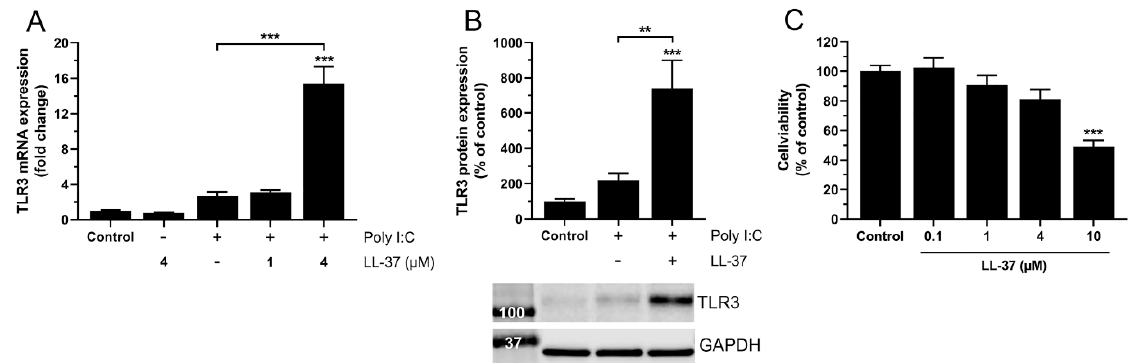
Figure 4. High but not low concentration of LL-37 stimulates poly I:C-induced upregulation of TLR3 in BEAS-2B cells. ( A ) TLR3 mRNA expression was evaluated using quantitative real-time RT-qPCR in cells treated with poly I:C (0.2 µg/mL), LL-37 (4 µM) or LL-37 (1 and 4 µM) and poly I:C (0.2 µg/mL) in combination for 24 h. ( B ) TLR3 protein expression was evaluated using Western blot in cells treated with poly I:C (0.2 µg/mL) alone or poly I:C in combination with LL-37 (4 µM) for 24 h. The TLR3 immunoreactive band was observed at the expected molecular weight of 115-130 kDa and normalized to GAPDH (37 kDa) serving as internal control. ( C ) Cell viability was assessed using the MTT assay in cells treated with LL-37 (0.1, 1, 4 and 10 µM) for 4 h. ( A - C ) Data are presented as mean ± SEM, n = 8 ( A , B ) and n = 6–8 ( C ) in each group. Statistical significance was calculated using a one-way ANOVA, followed by Tukey’s post hoc test. *** represents p < 0.001 vs. control. For comparisons indicated by the bars, ** and *** represent p < 0.01 and p < 0.001, respectively.